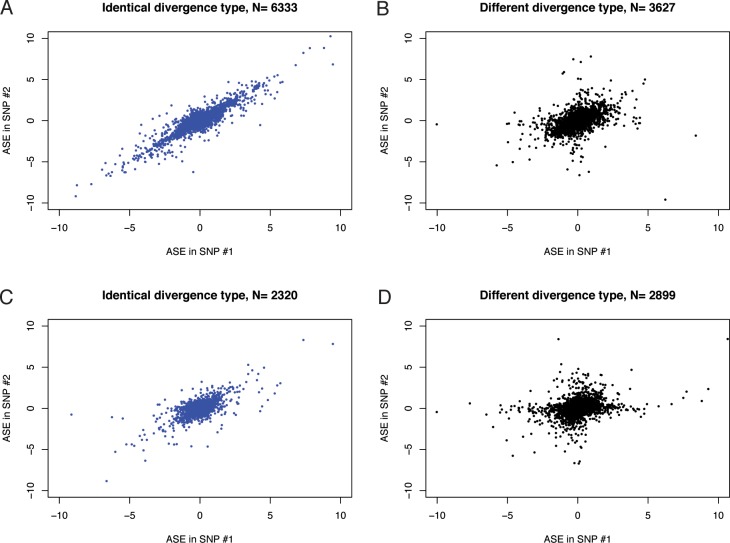
Correlation of ASE (log-fold change of RNA-seq counts of marine over freshwater allele) in different pairs of SNPs was used to perform concordance analysis.(a) SNPs assigned to same exons and showing identical type of genetic divergence (concordant SNPs). (b) SNPs assigned to same exons but showing different classes of genetic divergence (discordant SNPs). (c) SNPs assigned to different exons of the same transcript and showing identical type of genetic divergence. (d) SNPs assigned to different exons of the same transcript and showing different type of genetic divergence.